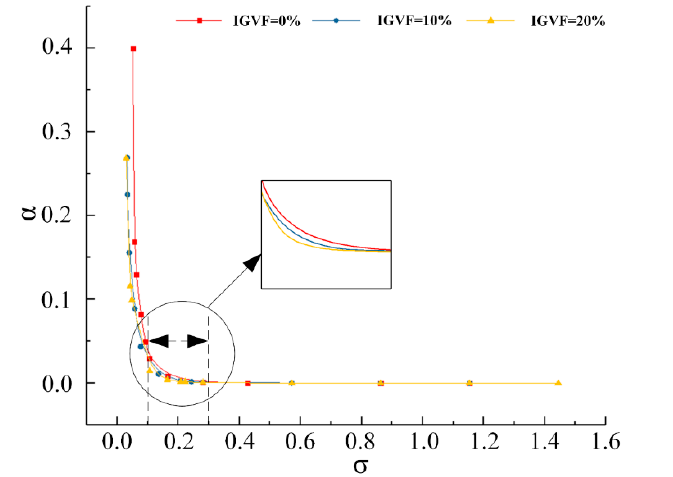
Figure 7. The cavitation characteristic curve.